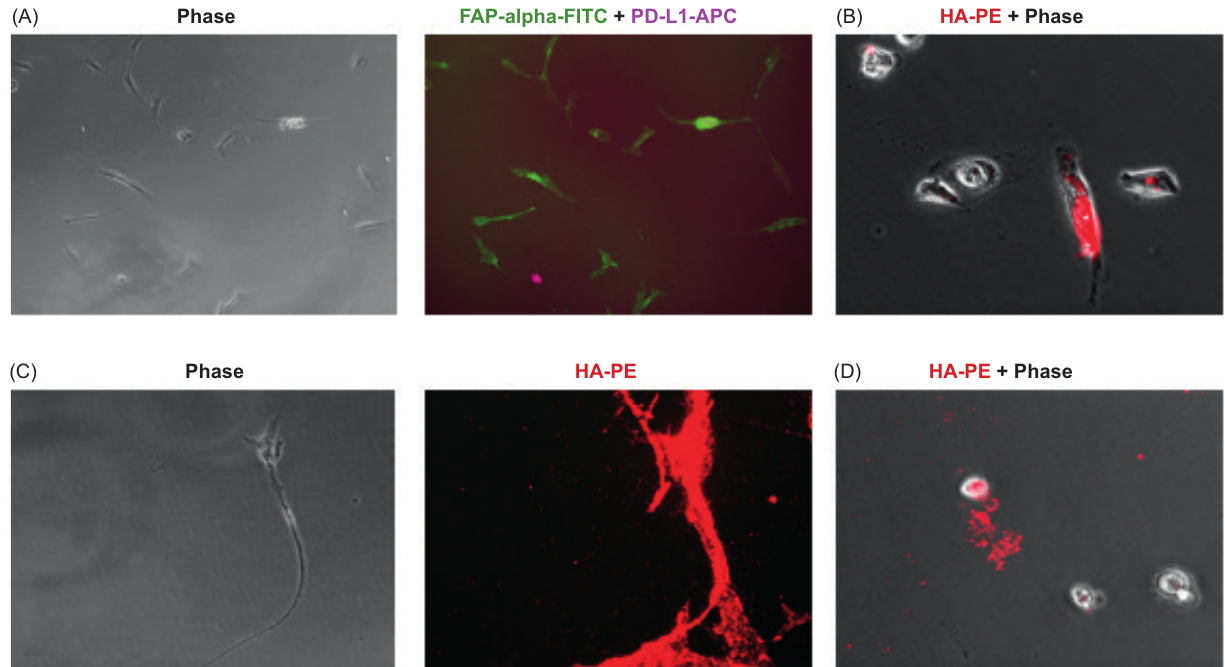
Figure 4: Detection of cancer-associated fibroblasts in kidney tumor stroma. The tissue slices were cultured for 7 days. Non- adherent cells were carefully removed from the plate. Plate with remaining adherent cells washed with PBS and fixed with 4% formaldehyde. Plate-bound cells were stained with FAP-alpha-FITC and PD-L1-APC (image A) antibodies. To visualize the tumor-produced HA, biotinylated HA-binding protein and PE-labeled Streptavidin were subsequently added (images B, C, D). Representative images are